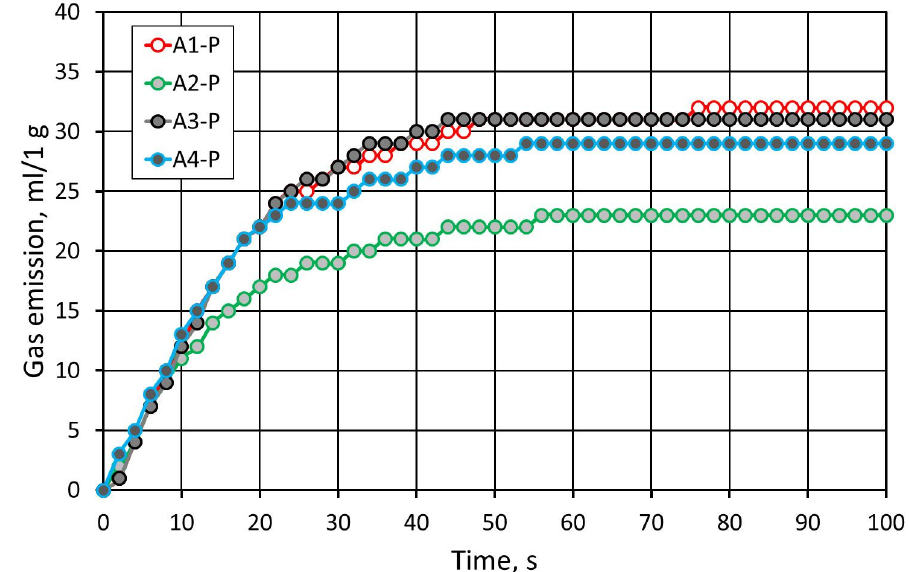
Figure 12. Comparison of the gas emissivity of the molding sand made on the Pioma Foundry (P) sand with various binders in the alkali-phenolic process for the constant resin content of 1.2 wt.% and 25% of hardener.